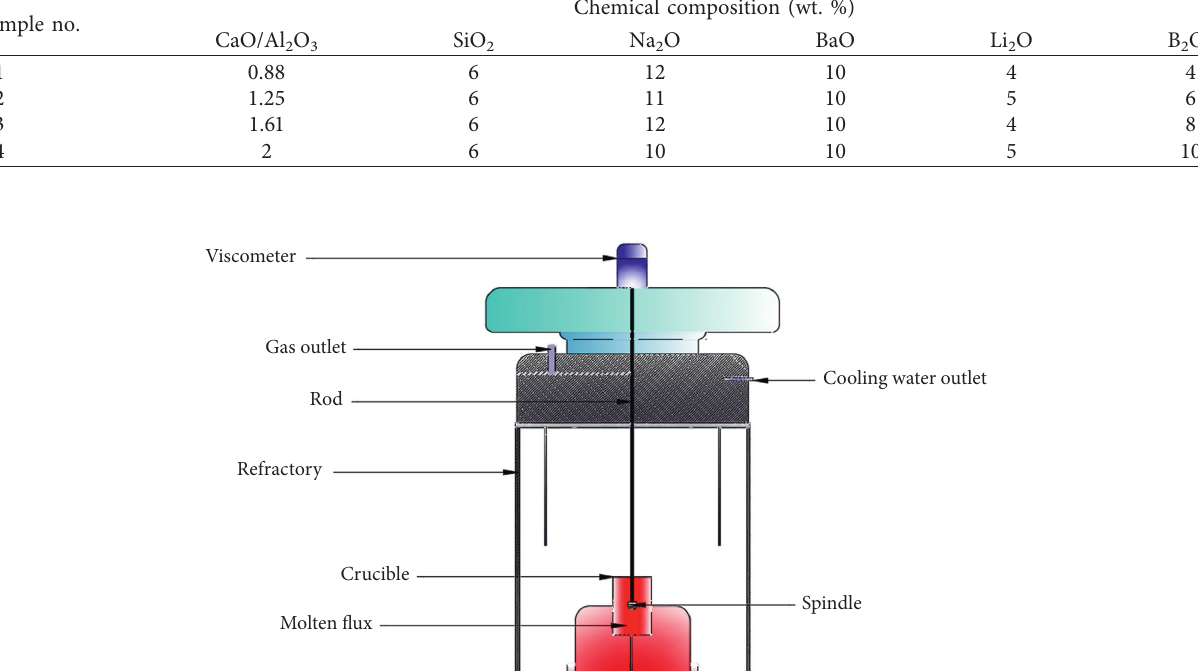
Table 1: Measured chemical composition of mold fluxes (wt. %). Sample